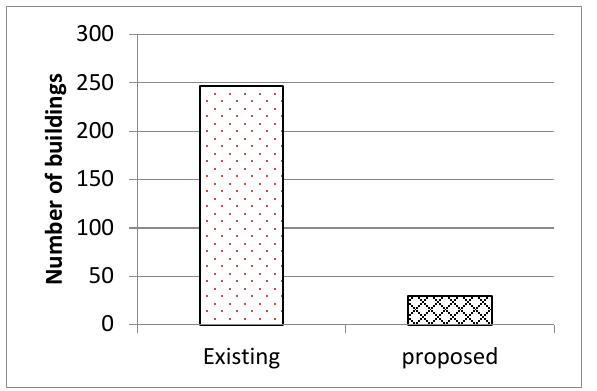
Figure 3. Comparison of the number of buildings for the existing and proposed development.